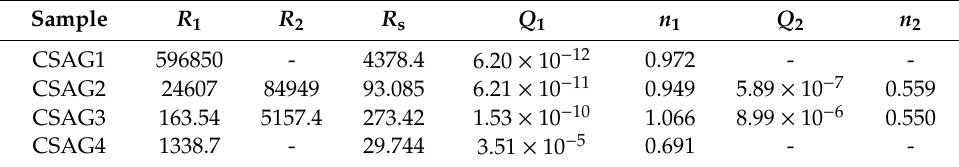
Table 3. The ethylene carbonate (EC) parameters of each film at room temperature.